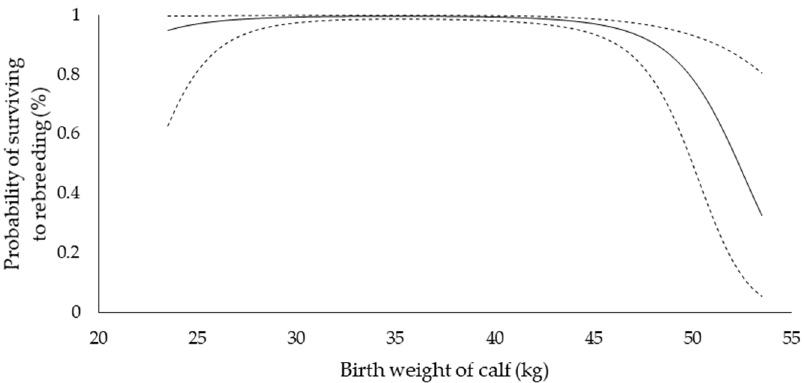
Figure 3. Probability of survival to rebreeding for mixed-aged cows having produced calves of different birth weights. Dashed lines indicate limits of a 95% confidence interval.